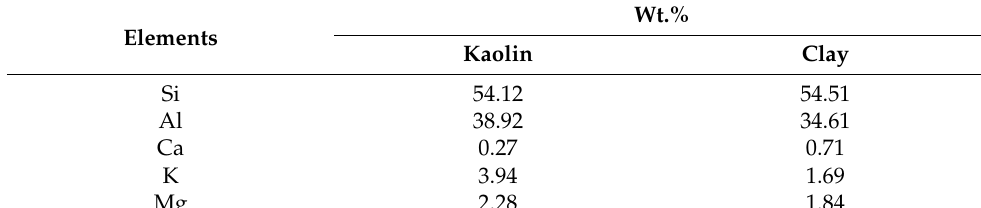
Table 2. Elemental analysis (XRF) of the kaolin and clay.